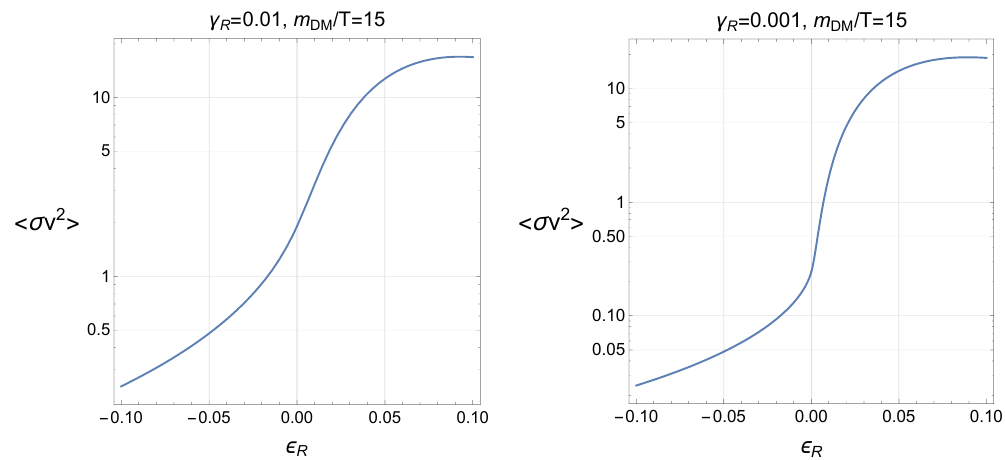
Figure 2 . Thermal-averaged 3 ! 2 annihilation cross section near resonance as a function of (cid:15) R . Here, the cross section is given in arbitrary unit, so only the relative ratio at di(cid:11)erent values of (cid:15) R is